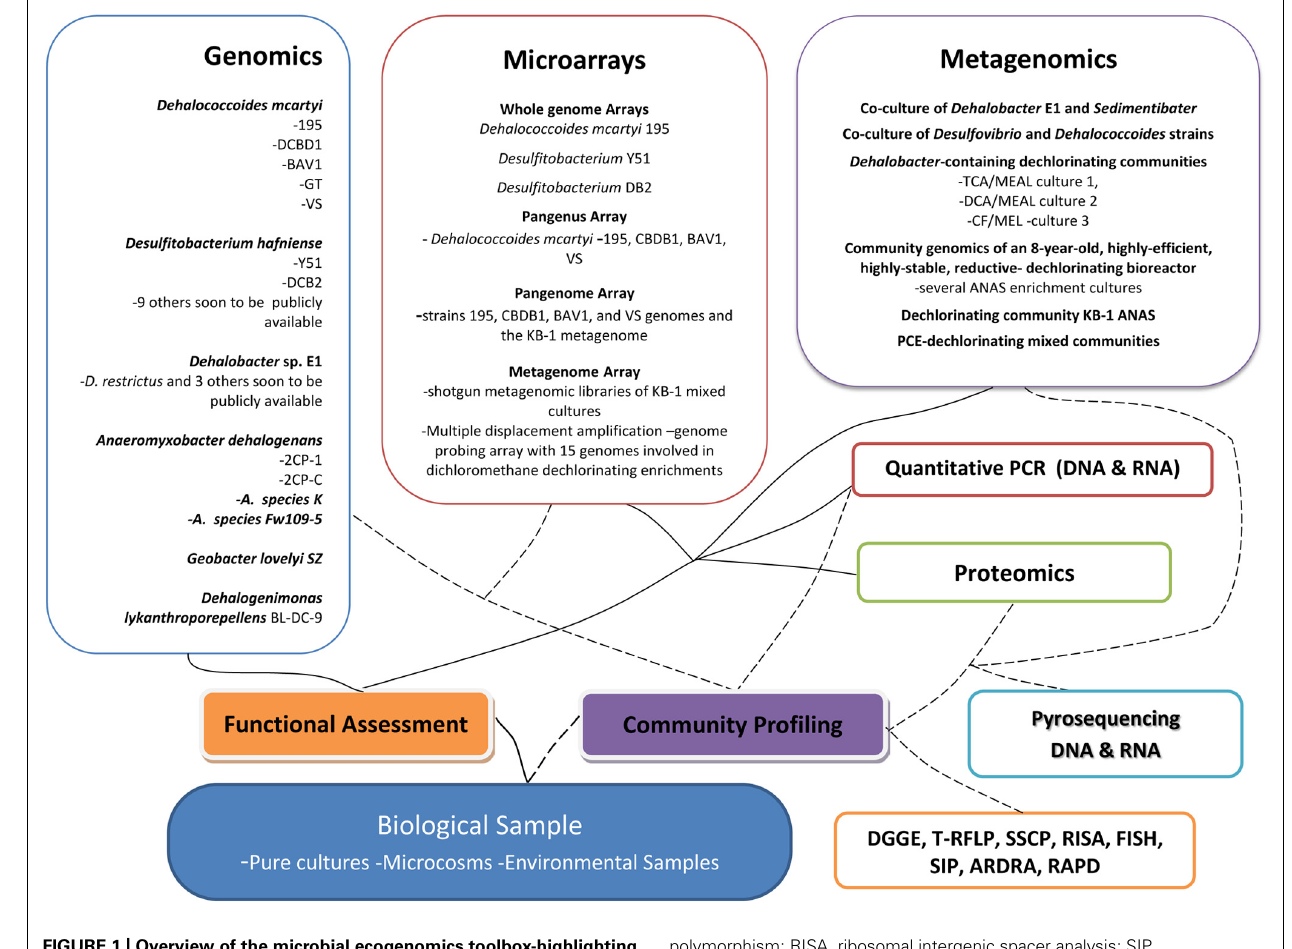
FIGURE 1 | Overview of the microbial ecogenomics toolbox-highlighting key some results and developments gained or obtained by techniques. DGGE, denaturing gradient gel electrophoresis;T-RFLP, terminal restriction fragment length polymorphism; SSCP, single strand conformation